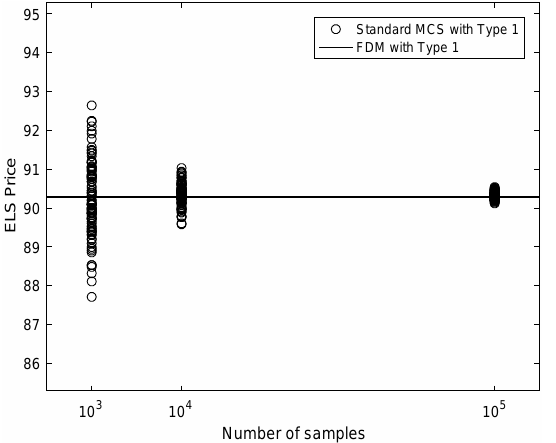
Figure 6. Type 1 equity-linked securities (ELS) price versus the number of samples. Here, we plot 100 simulation results for each case.